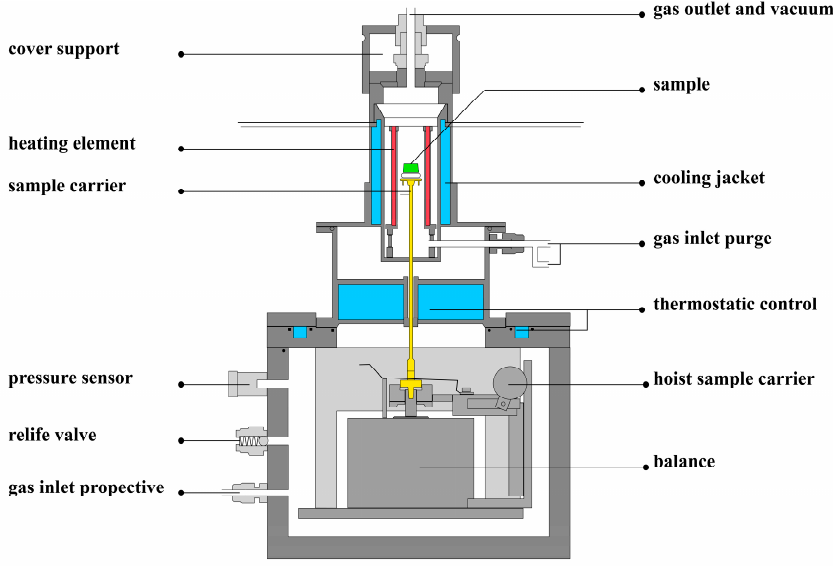
Figure 3. Thermal analyzer schematic diagram.